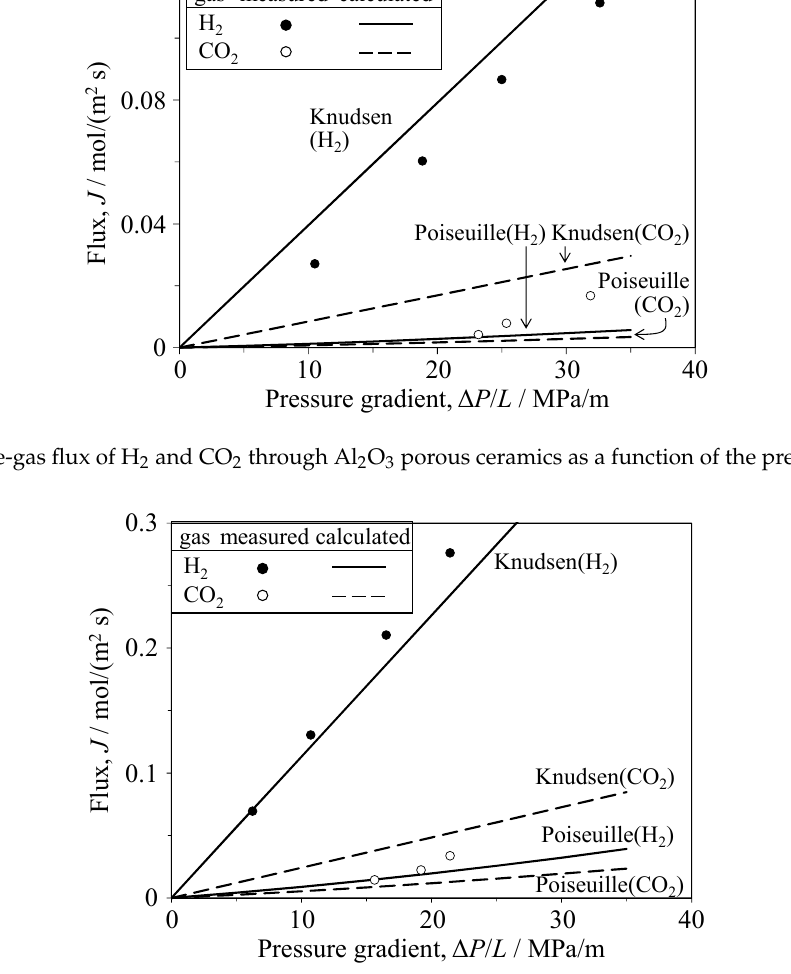
Figure 7. Single-gas flux of H 2 and CO 2 through YSZ porous ceramics as a function of the pressure gradient.